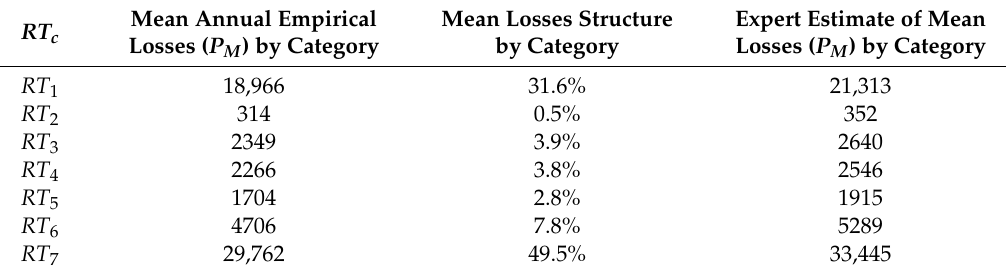
Table 8. Expert estimate of mean losses ( P M ) by risk category RT C in 1000s of